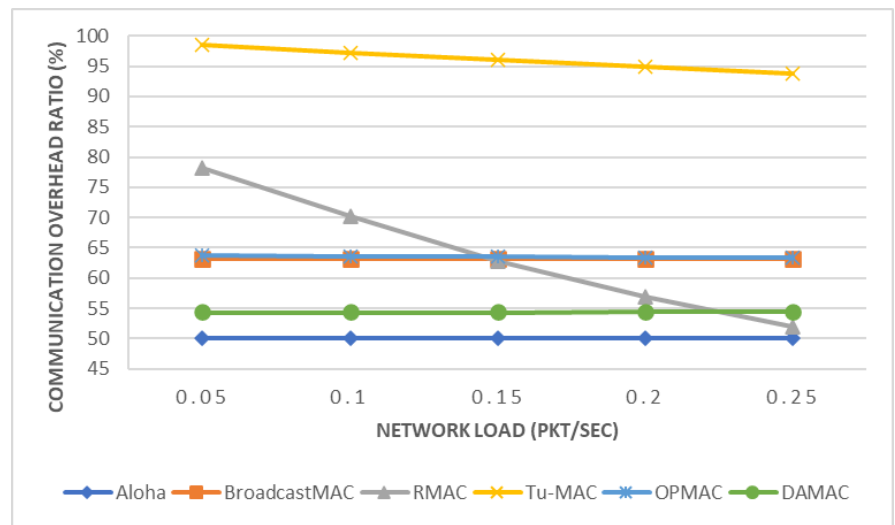
Figure 6. Communication Overhead